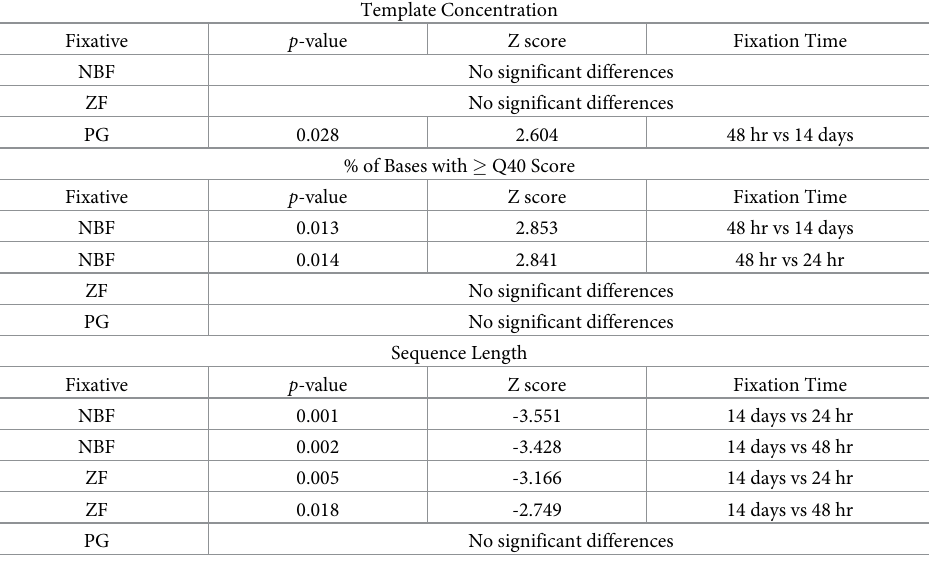
Table 1. Kruskal-Wallis non-parametric ANOVA results: Significant differences in template concentration used in PCR and Sanger sequencing results for each fixative between fixation times. Template